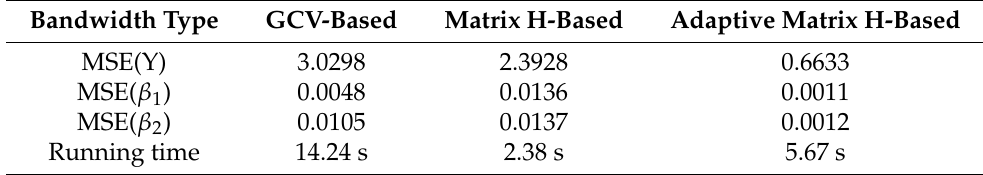
Table 1. MSE results of the GCV-based bandwidth h, the bandwidth matrix H and the adaptive bandwidth matrix for N = 200